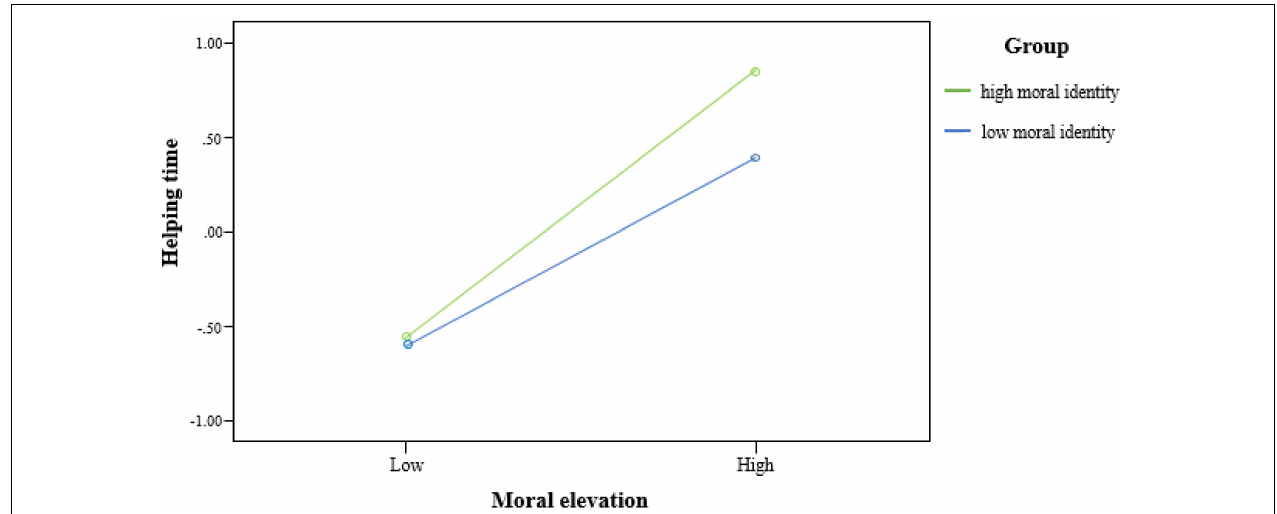
FIGURE 2 | The relationship between moral elevation and helping time for high and low levels of moral identity.